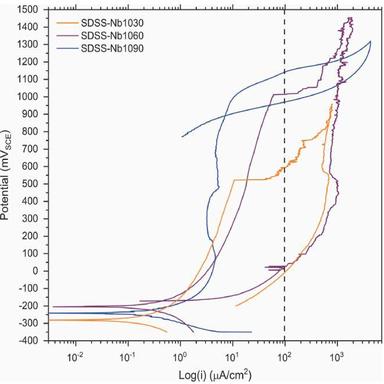
Cyclic polarization curves of heat-treated SDSS-Nb samples, 3.5% NaCl solution at 25 ◦C.